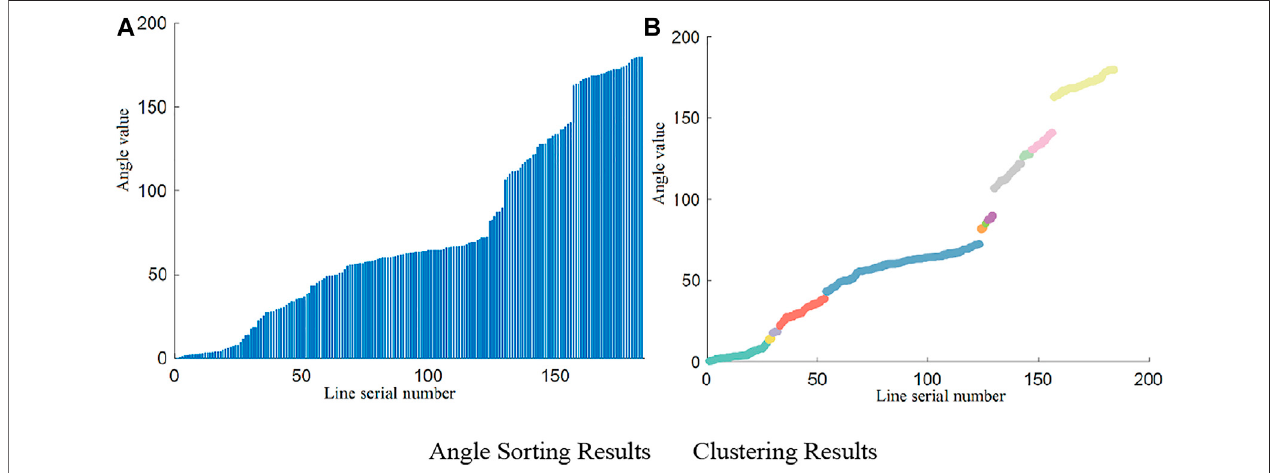
FIGURE 6 | Sorting and clustering of angles. (A) Angle sorting results. (B) Clustering results.